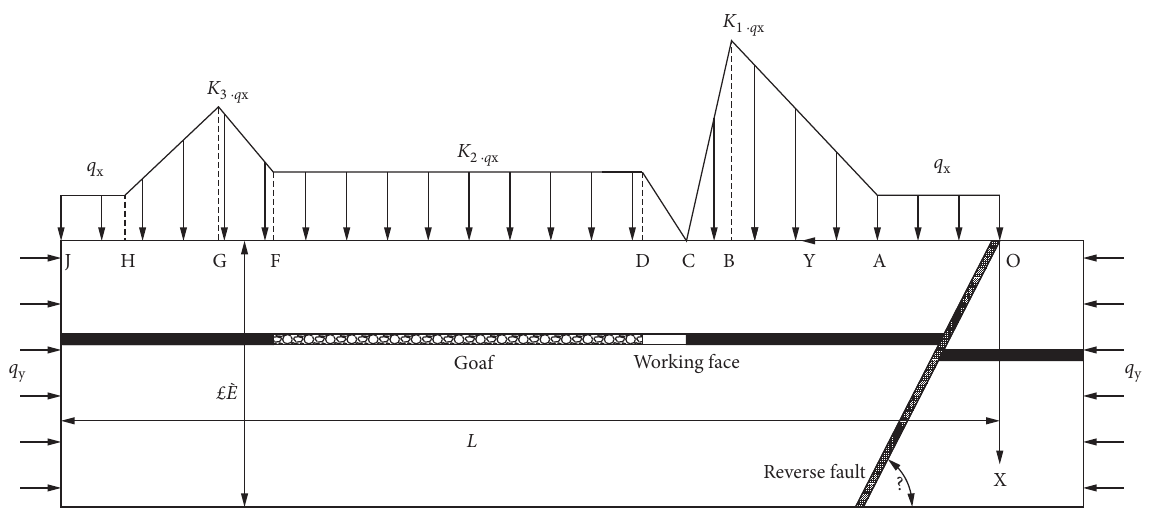
Figure 1: Mechanical model of mining coal under the influence of reverse